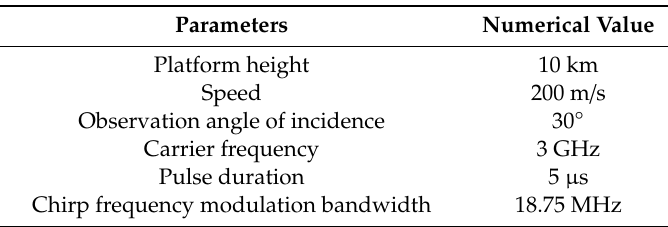
( b ) Figure 5. Ocean surface echo signals as follows: ( a ) wind speed of 10 m/s and ( b ) wind speed of 15 m/s. When a SAR images the ocean surface, the scanning band generated by the electromagnetic wave needs to sweep across the ocean surface; that is, the ocean surface needs to be located in the SAR imaging coordinate system. Since the simulated ocean area was approximately 1 km × 1 km, for the SAR, the width was small enough to cause ground bending. Therefore, without considering factors such as the rotation of the Earth and curvature of the ground and taking the subsatellite point as the origin, the projections of the SAR azimuth and range were the x and y axes, and the SAR imaging coordinate system was established. The reason for establishing the coordinate system in this way is that the azimuth and range are perpendicular to each other. Other parameters of the SAR system are the same as those in Table 1.